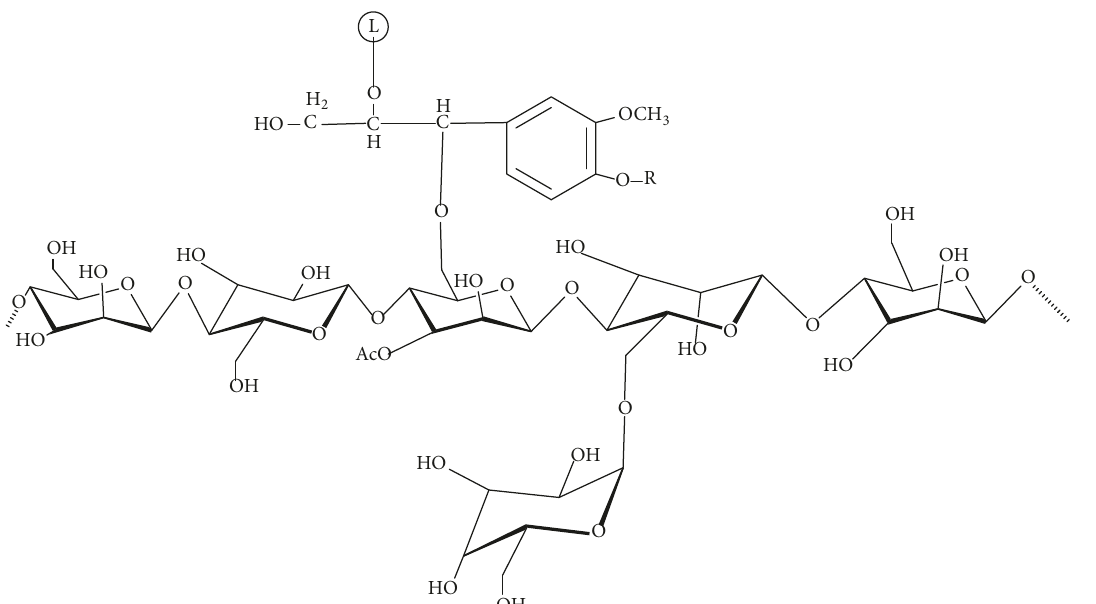
Figure 1: (Galacto)glucomannan in softwood hemicelluloses with linkage to lignin moieties (R = H or polylignol; L = polylignol).